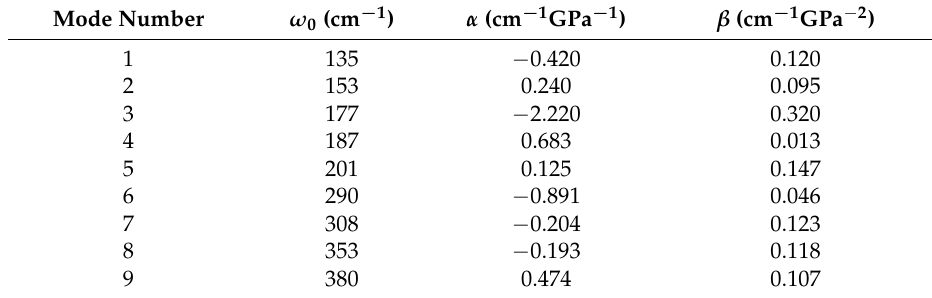
Table 1. Relationship between the pressure and the Raman shift for orpiment as fitted with equation: ω ( P ) = ω 0 + α P + β P 2